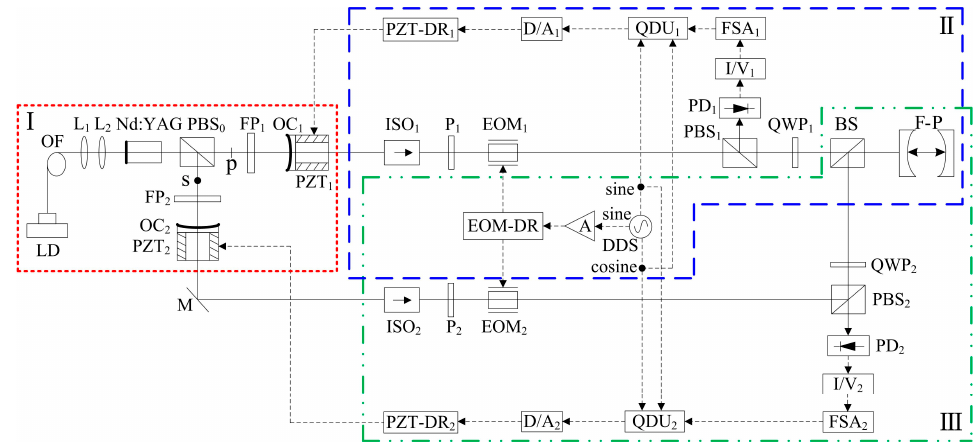
Figure 39. Schematic diagram of the frequency-difference-stabilizing system for the TCDFL using the double-modulator QD-PDH frequency-stabilizing method [43]. LD: laser diode; OF: optical fiber; L: lens; PBS: polarizing beam splitter; FP: F-P etalon; OC: output coupler; PZT: piezoelectric